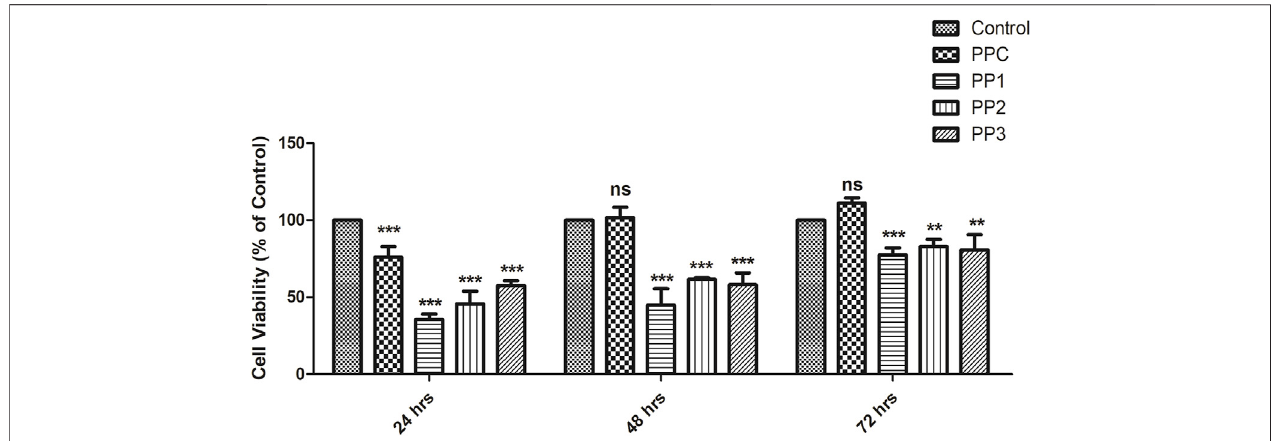
FIGURE 6 | Viability of 3T3 fi broblasts cells seeded in different groups of hydrogels determined by XTT assay. The control group (doted bar) represents 3T3 fi broblasts cells seeded without any hydrogel. Cells exhibit high viability indicating absence of cytotoxic effect of hydrogels. * p denotes statistical signi fi cance: * p < 0.05; ** p < 0.01; *** p < 0.001.